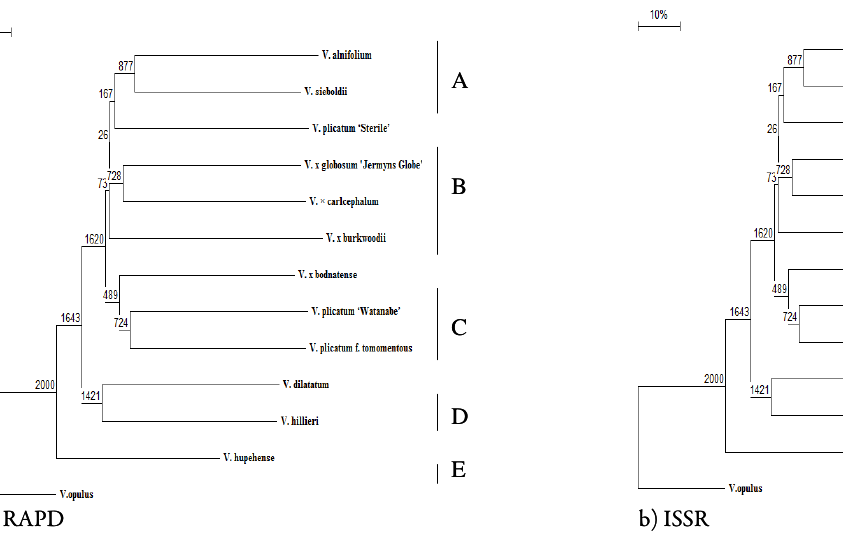
Fig. 2. Dendrograms generated using unweighted pair group method with arithmetic average analysis, showing relationship between Viburnum genotypes, using RAPD a) and ISSR b) data. The number at the forks indicate the confidence limits for the grouping of those species in a branch occurred, based on 2.000 pseudoreplications in bootstrap analysis Tab. 3. Genotype-specific ISSR products generated for 13 genotypes